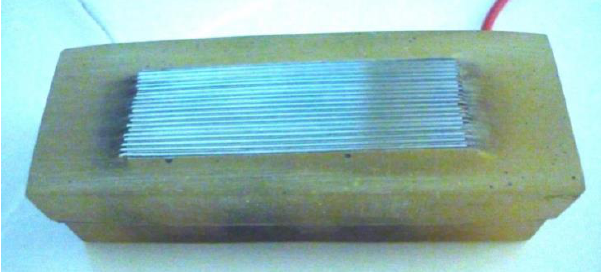
Figure 3. Examples of sensors based on microcells in a bimetallic batch sensor: plates of mild steel and copper with a thickness of 0.1 – 0.25 mm are separated by a layer of mica with a thickness of 0.1 – 0.2 mm [56].